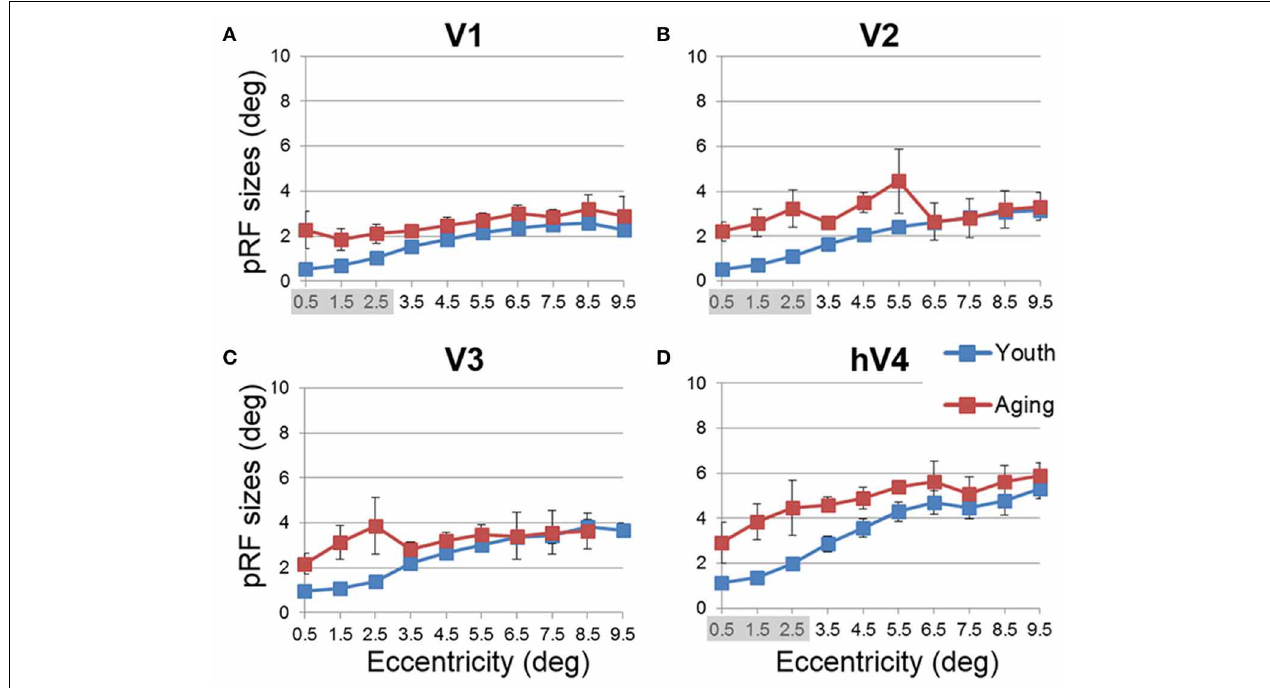
FIGURE 9 | Average population receptive field size measurements for visual field maps in young and healthy aging subjects. (A) V1. (B) V2. (C) V3. (D) hV4. Blue lines represent data from healthy young subjects, and red lines represent data from healthy aging subjects. Each bar represents data measured in individual subjects and then